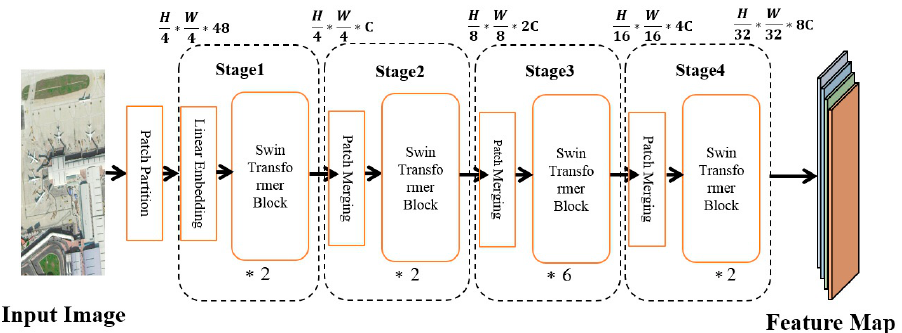
Figure 2. The architecture of the Swin Transformer.